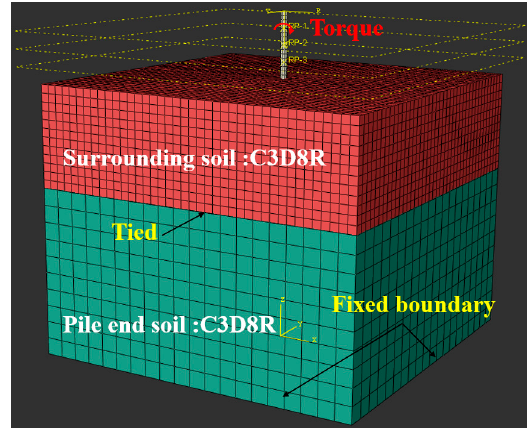
Figure 3. Mesh of the Finite element model.